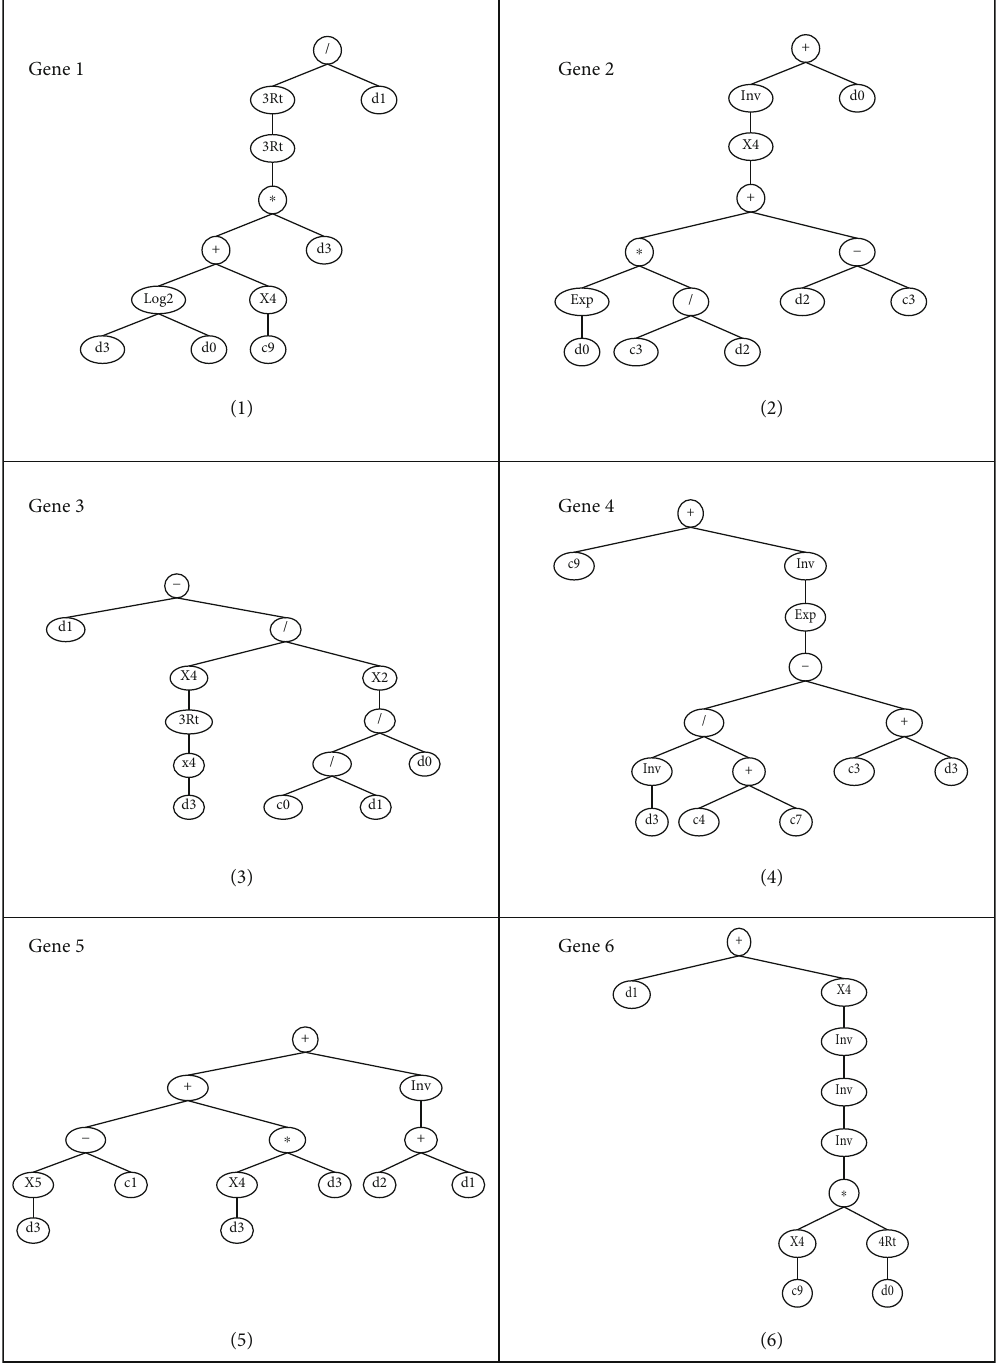
Figure 8: Expression trees of genes 1 –